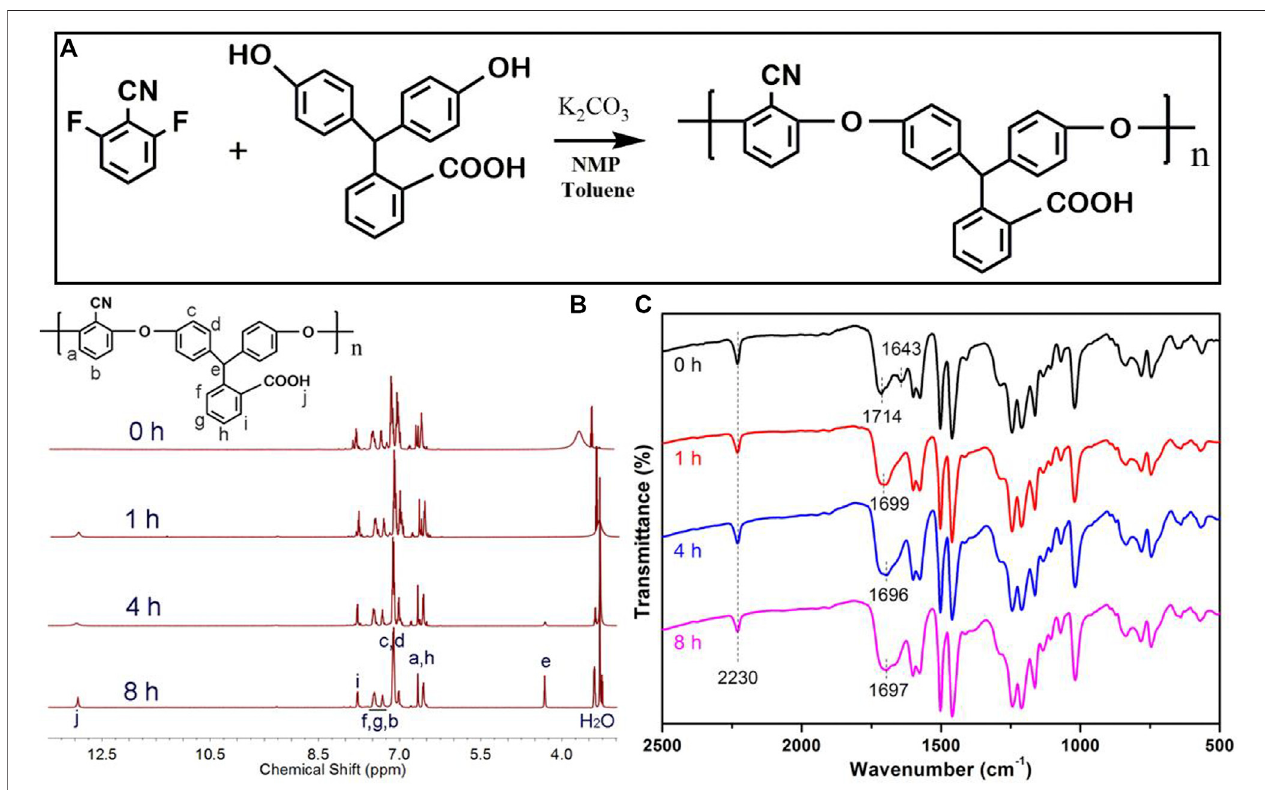
FIGURE 1 | The synthetic route (A) for super-engineering polyarylene ether containing pendent nitrile and carboxylate (PAE-NC), 1H NMR spectra (B) , and FTIR spectra (C) of synthesized PAE-NC and PAE-NC subject to alkaline hydrolysis for a different time.